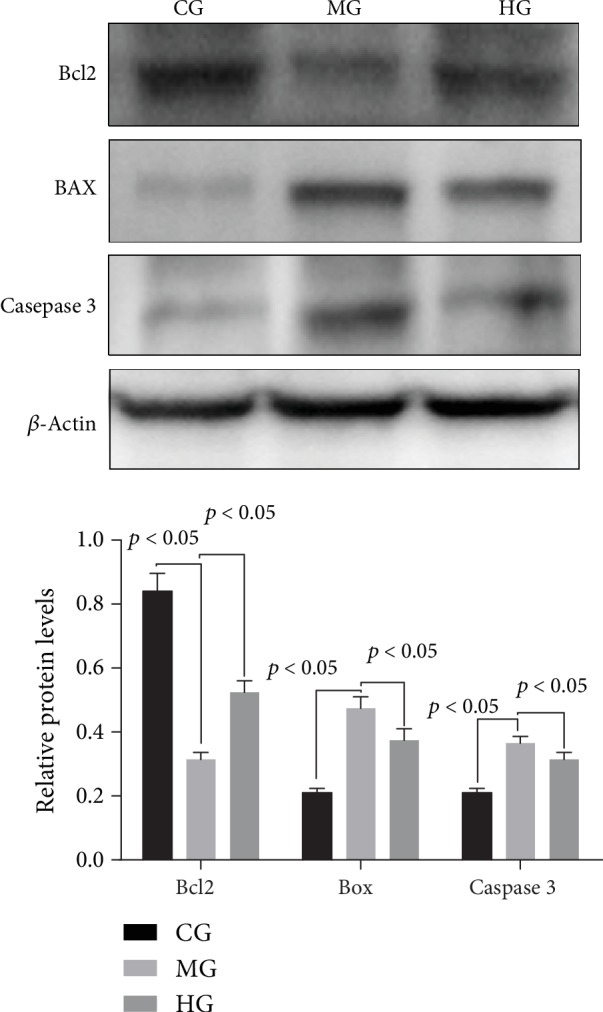
Western blot analysis of the effects of hydrostatin-SN10 on apoptotic markers (Bcl2, BAX, and caspase 3). n = 12 for each group, and statistical difference was significant if p < 0.05.